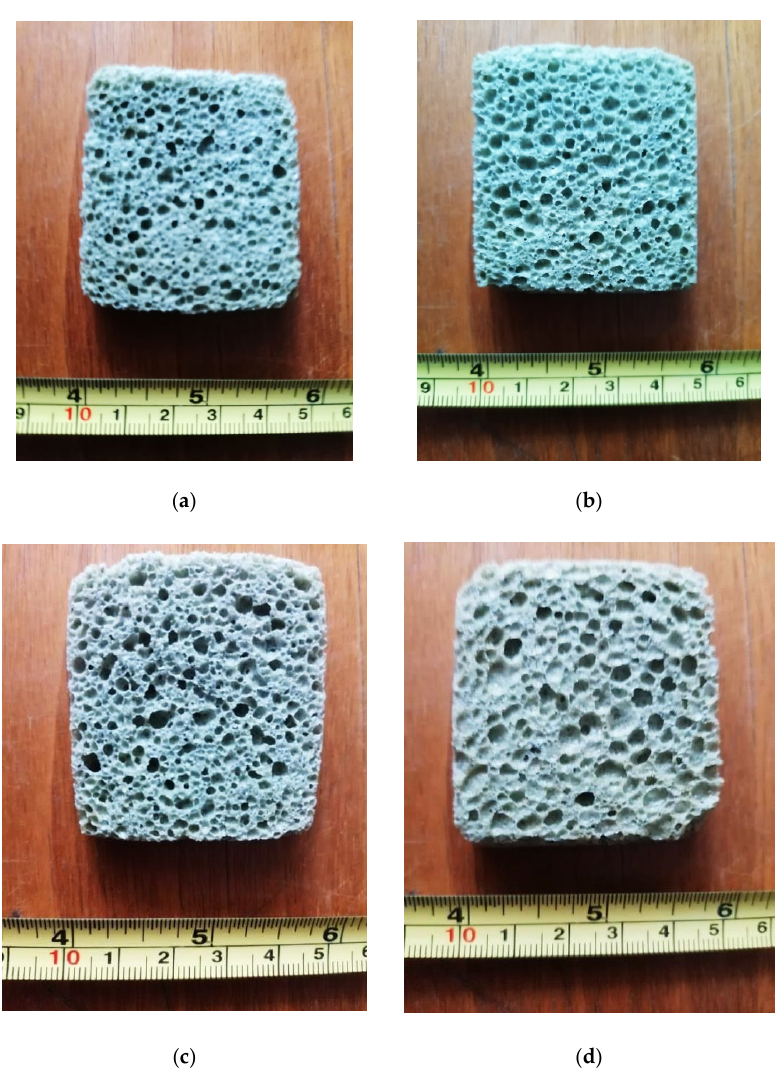
Figure 2. Appearance of the glass foam samples (cross section) corresponding to: variant 1 ( a ); variant 2 ( b ); variant 3 ( c ) and variant 4 ( d ).